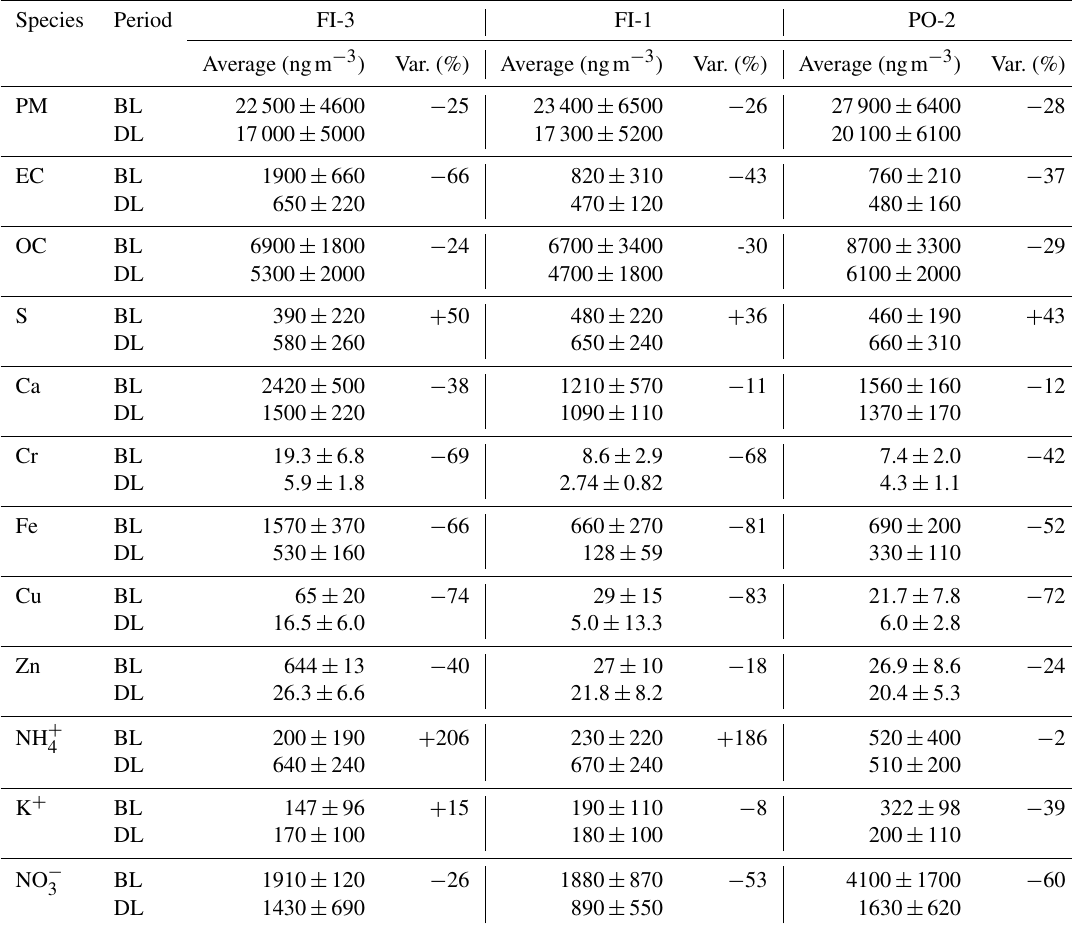
Table 5. Average concentrations ( ± standard deviation) of the main chemical species for the three sampling sites and their relative variation between the period before lockdown (BL) and during lockdown